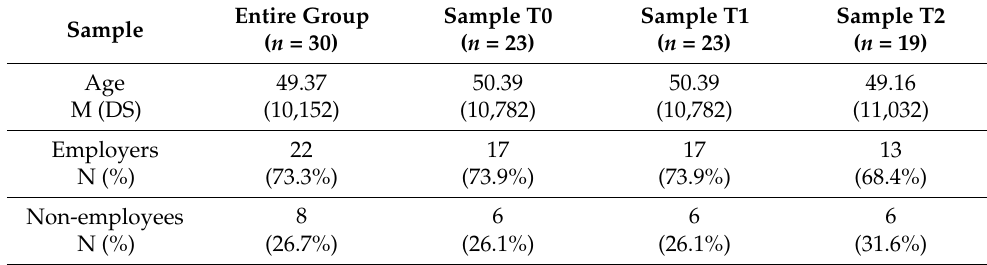
Table 1. Characteristics of the